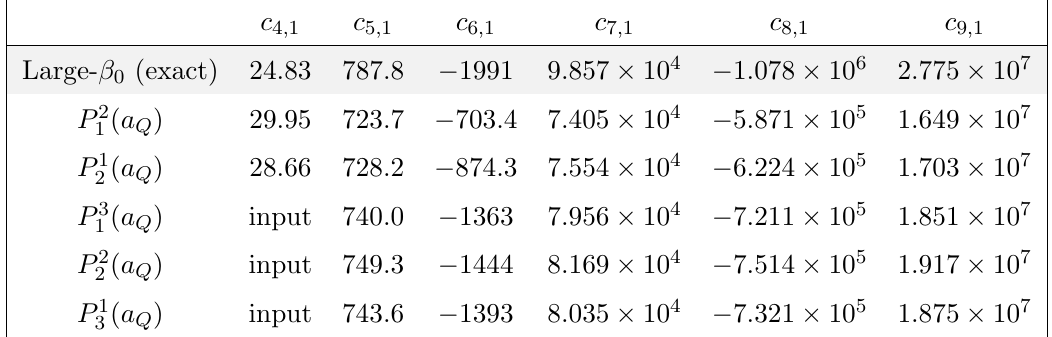
( a Q ) to the FOPT (cid:11) s =(cid:25) expansion of M